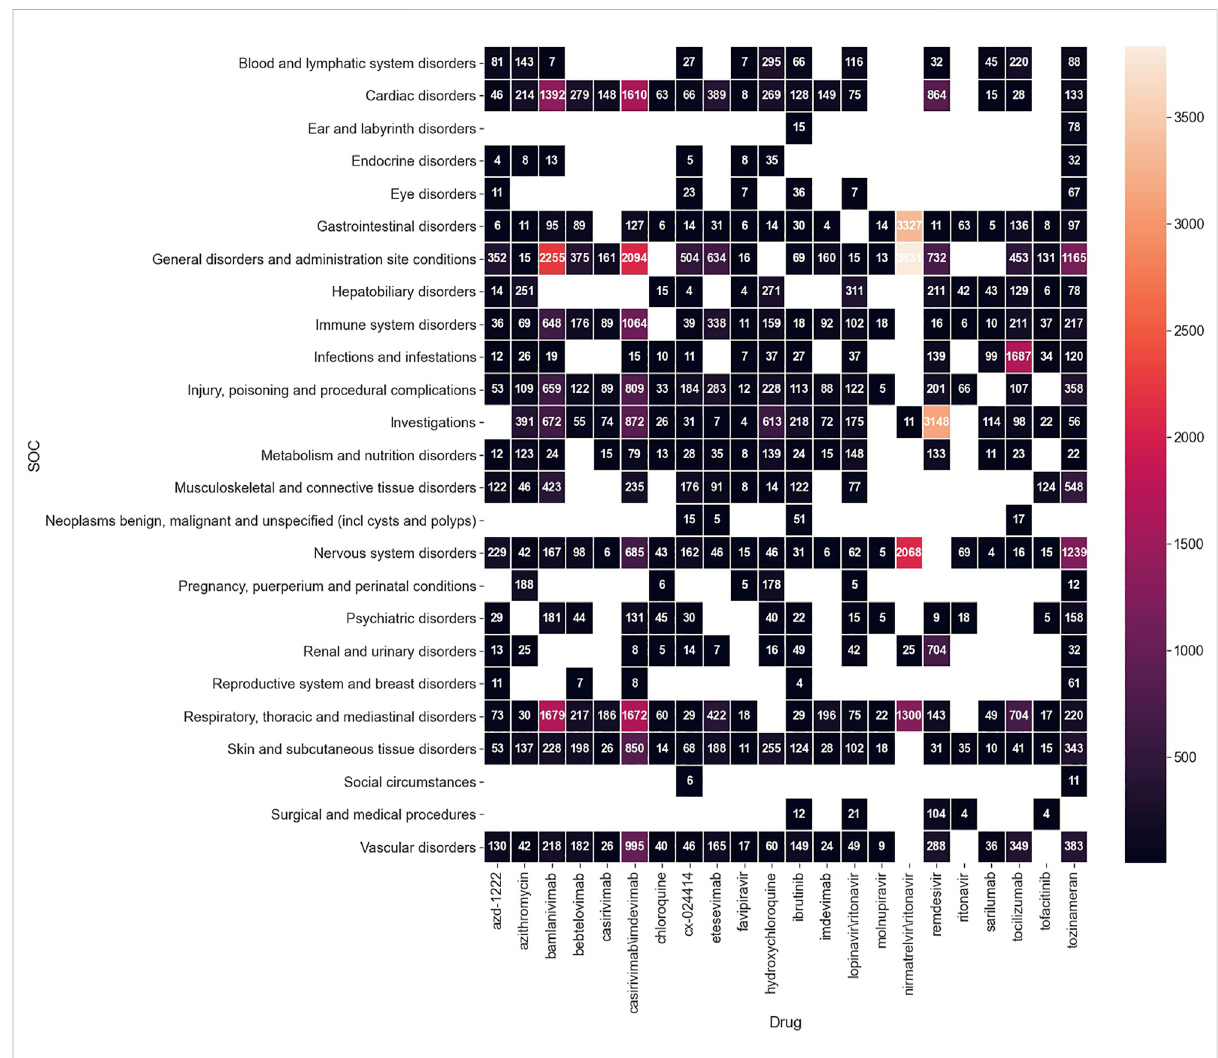
FIGURE 3 Number of reported cases of signi fi cant ADE signals on the SOC